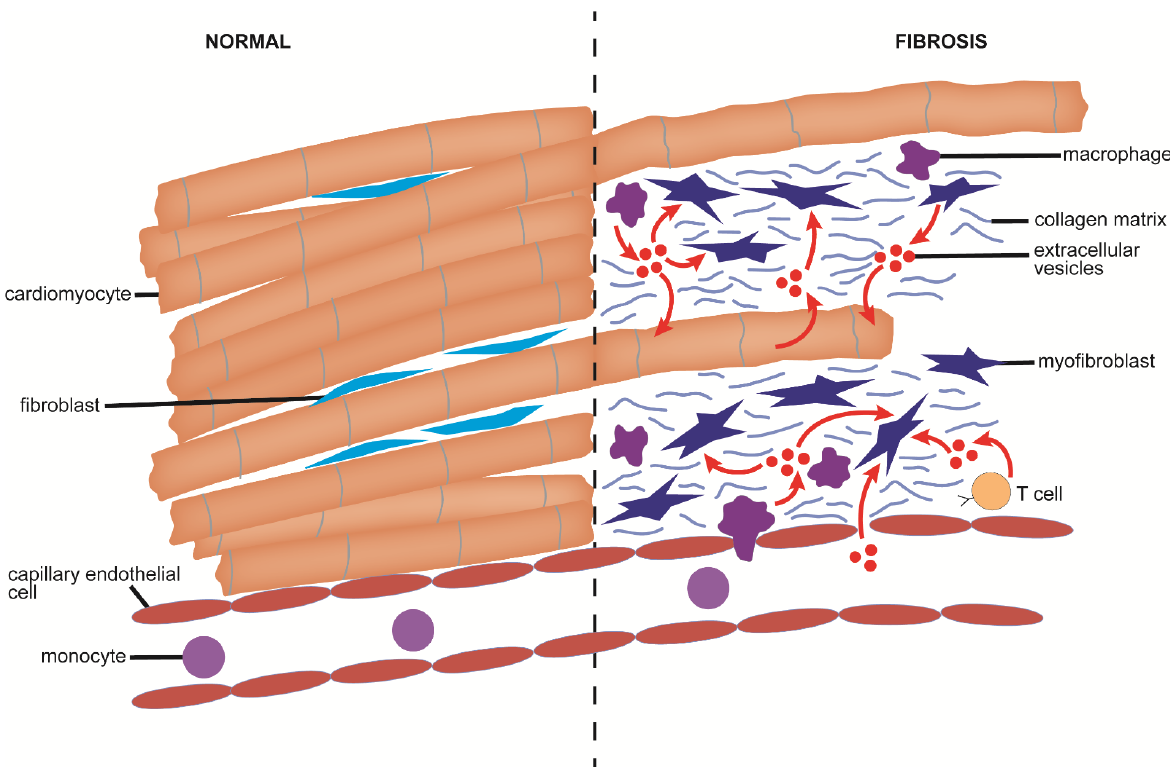
Figure 5. Proposed EV pathways in the pathogenesis of cardiac fibrosis. Cardiomyocytes exposed to stress such as hypoxia produce EVs that promote mesenchymal transition, survival, and fibrogenesis in cardiac fibroblasts/myofibroblasts in part due to delivery of enriched EV cargo components that include Neat 1, miR-29b-3p, miR-30d-5p, miR-100-5p, miR181a, miR-21 and miR-208a, the latter two of which target, respectively, AKT- PTEN and Dyrk2 . TNF- α -stimulated cardiomyocytes and cardiac fibroblasts produce EVs that are exchanged between them and which can promote increased oxidative stress by delivery of Nrf2 -tartgeting miR-27a, -28-3p, or -34a, while profibrotic pathways in cardiac fibroblasts are promoted by delivery of fibroblast EVs enriched with Wnt3a or Wnt5a. High glucose-stimulated macrophages produce EVs that are enriched in HuR which is required for EV-stimulated expression of inflammatory or fibrogenic genes in cardiac fibroblasts. Macrophage EVs are also enriched in miR-155 which exerts, firstly, anti-proliferative and pro-inflammatory effects in cardiac fibroblasts by targeting Son of Sevenless 1/SOCS1 and, secondly, pyroptosis, hypertrophy and fibrosis in cardiomyocytes by its targeting of Foxo3a . Finally, age-related declines in HSP70 levels in serum EVs are associated with increased cardiac fibroblast proliferation. Only cells with a demonstrated role in EV production or response are shown; some of the depicted EV pathways are deduced from in vitro observations and have not been demonstrated in vivo. See text for details.